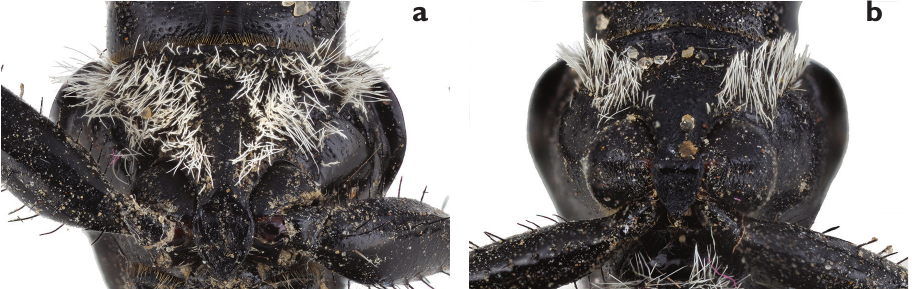
Figure 5. Ventral part of pronotum ( G. serrator ): a Male with dense white setae b Female with sparse white